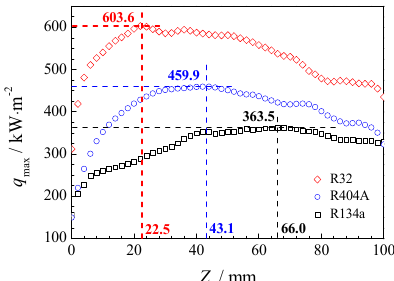
Figure 13. Variations in surface heat flux along axial spray distance.